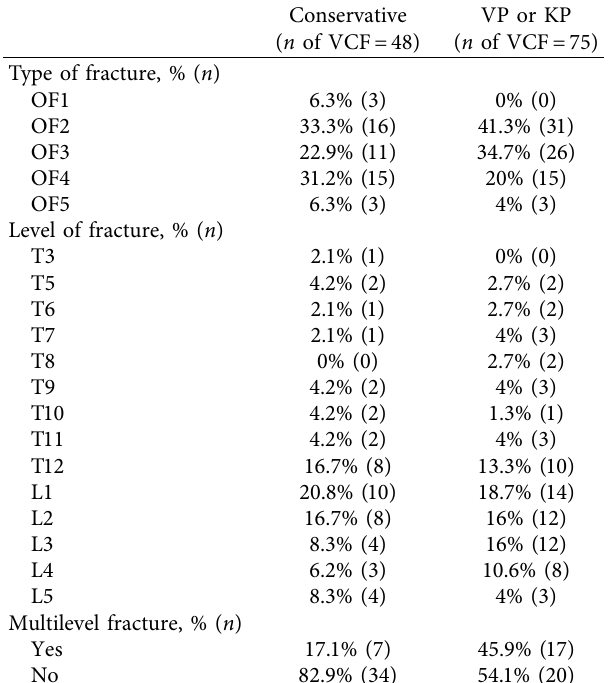
Table 1: Types and levels of fracture in the conservative and VP or KP